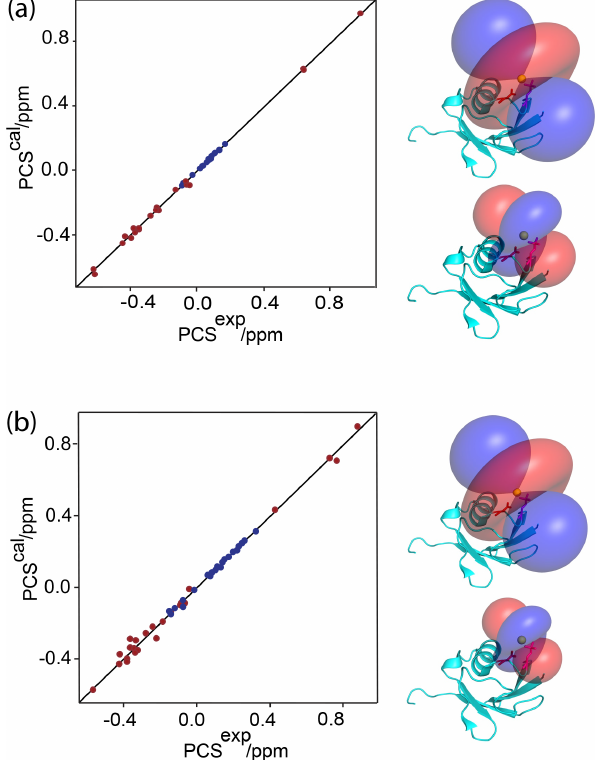
Figure 2. Correlation between back-calculated and experimental PCSs, and lanthanide locations on the ubiquitin mutants (a) E18Sep and (b) E16Q/E18Sep. Left panel: PCS data obtained with Tb 3 + and Tm 3 + plotted in red and blue, respectively. Right panel: blue and red PCS isosurfaces plotted on the protein structure and indi- cating PCSs of ± 1ppm, respectively. The isosurfaces illustrate the (cid:49)χ tensors obtained with Tb 3 + (upper structure) and Tm 3 + (lower structure). The side chains of E16 and the phosphoserine residue in position 18 are shown in a stick